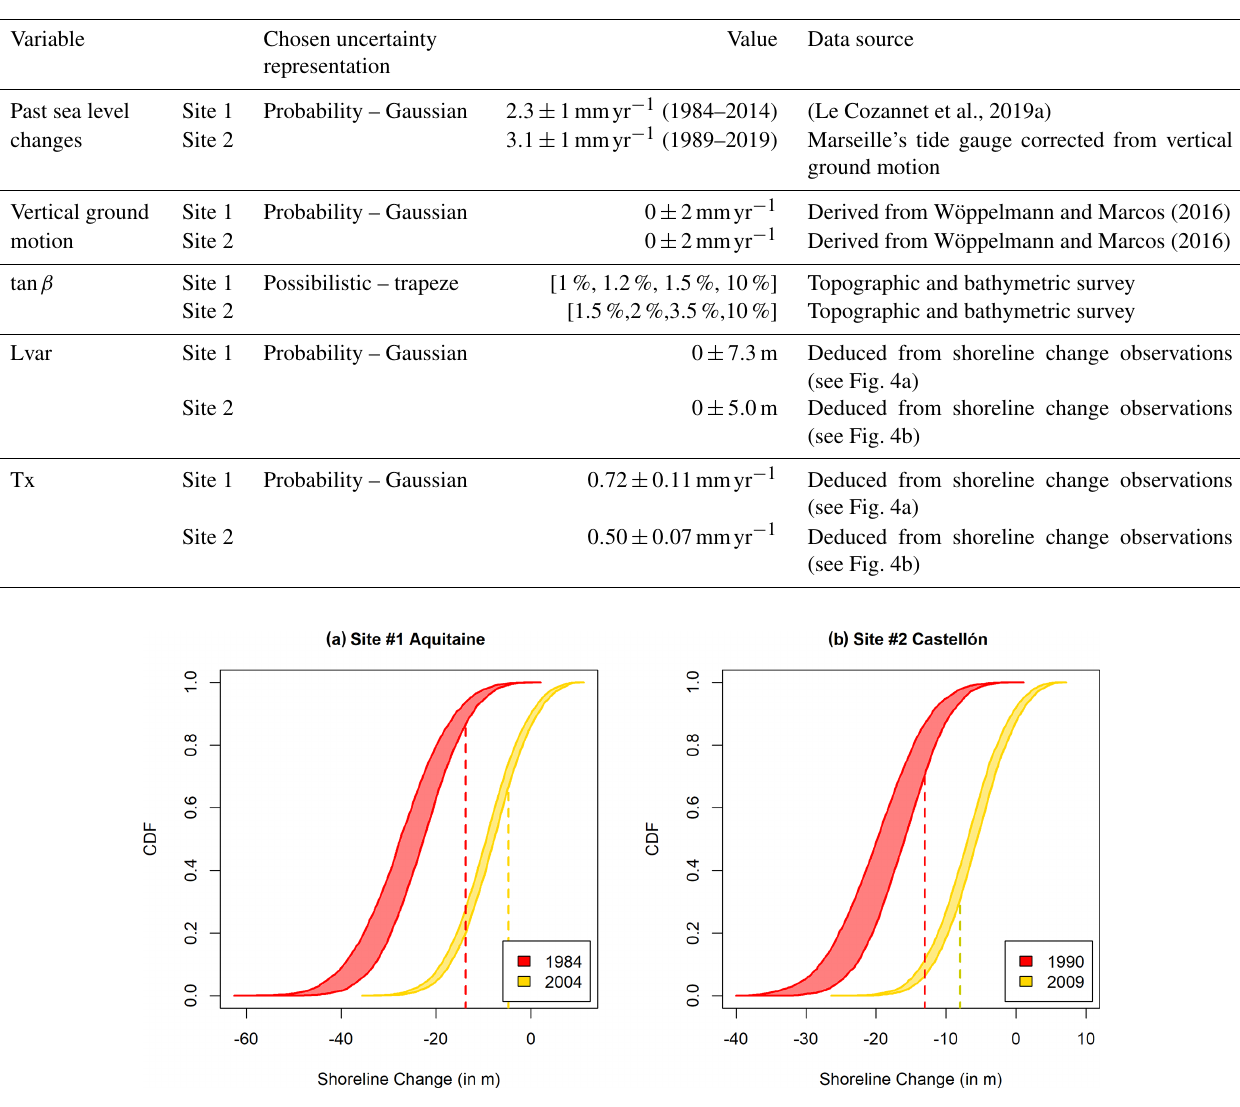
Figure 5. Past shoreline change probability boxes in (a) Aquitaine in 1984 and 2004 and (b) Castellón in 1990 and 2009, i.e. distant by 10 years (yellow) and 30 years (red) from the observational reference, respectively. The vertical dashed line indicates observed